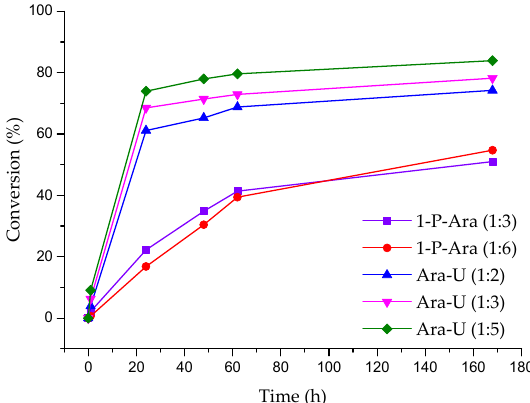
Figure 3. The dependence of the conversion of riboside 1a to arabinoside 1b on the type and amount of arabinose donor. The 1 mL reaction mixtures contained 1 mM modified riboside 1a ; 3 or 6 mM 1-P-Ara or 2, 3, or 5 mM Ara-U, 3.9 units PNP, 4.5 units UP in 2 mM potassium-phosphate buffer (pH 7.0).